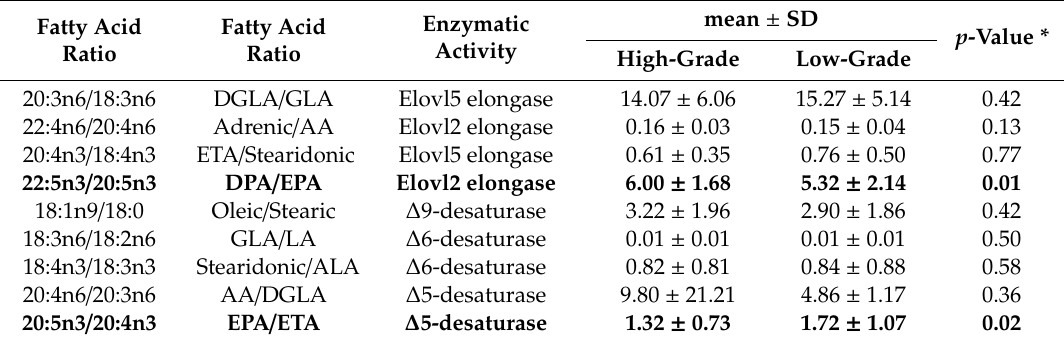
Table 5. Estimation of elongase and desaturase activity in high- and low-grade PCa groups.